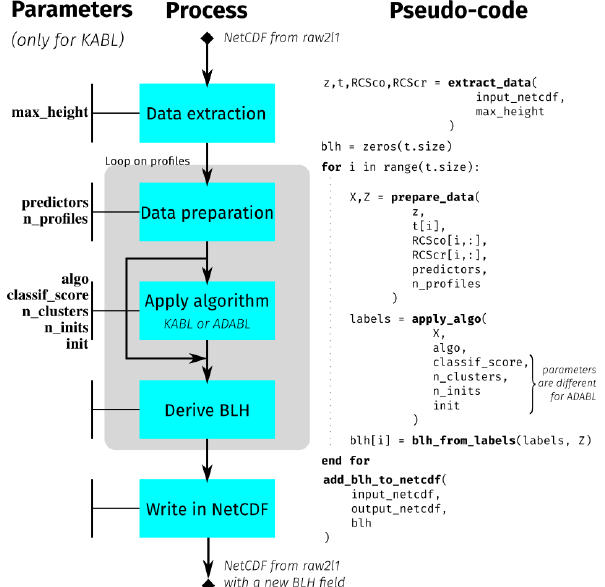
Figure 6. Simplified flowchart of the K -means for Atmospheric Boundary Layer (KABL) and AdaBoost for Atmospheric Boundary Layer (ADABL) algorithms with a focus on the KABL parameters. The parameters are described in Sect. 3.3 and in Table